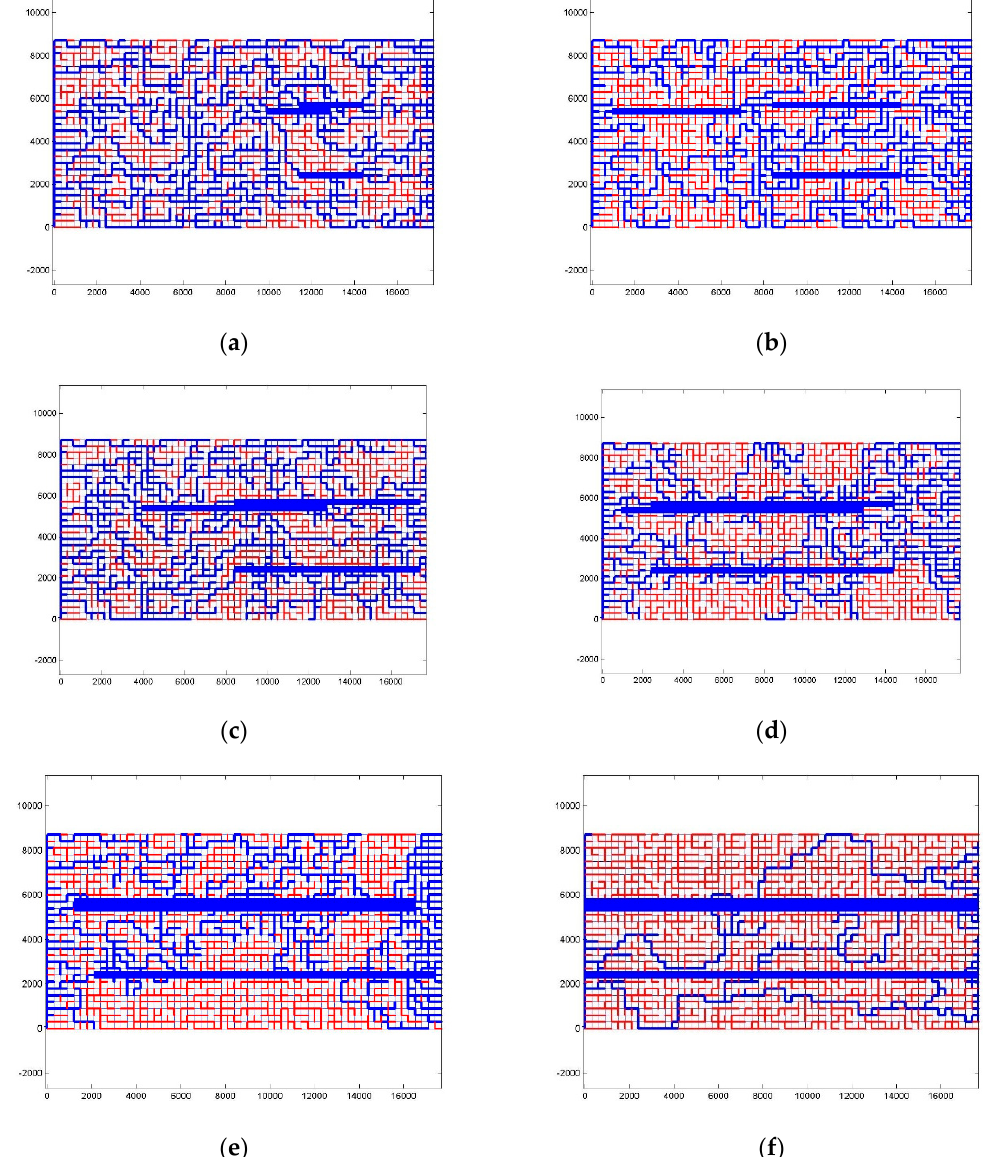
Figure 7. The distribution of oil/water at the end of the displacement with different fracture lengths in Type II (The red throats and fractures are filled with oil and the blue throats and fractures are filled with water). ( a ) l f / l = 0.17; ( b ) l f / l = 0.34; ( c ) l f / l = 0.5; ( d ) l f / l = 0.67; ( e ) l f / l = 0.84; ( f ) l f / l = N was first proposed by Moore and Slobod [46], Dimensionless capillary number c